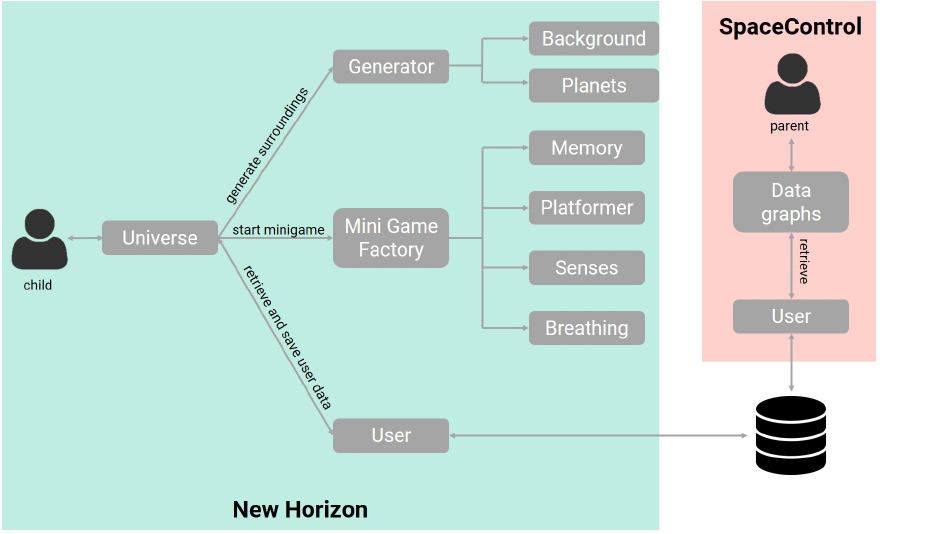
Figure 5. Overview of the different